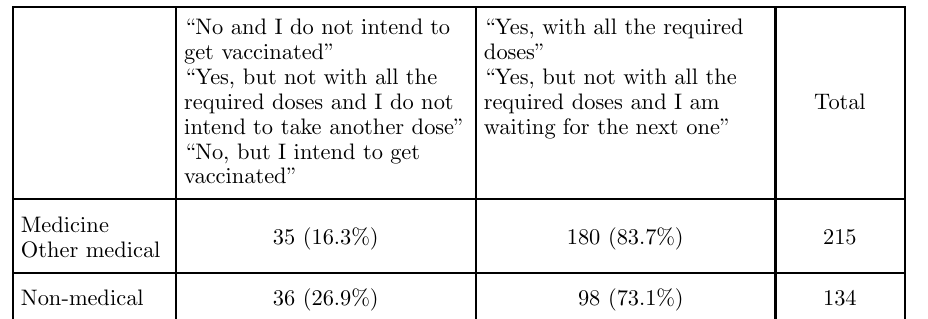
Table 1. Correspondence between faculty and COVID-19 vaccination “No and I do not intend to “Yes, with all the required get vaccinated” doses” “Yes, but not with all the “Yes, but not with all the required doses and I do not required doses and I am intend to take another dose” waiting for the next one” “No, but I intend to get vaccinated” Medicine 35 (16.3%) 180 (83.7%) 215 Other medical Non-medical 36 (26.9%) 98 (73.1%) 134